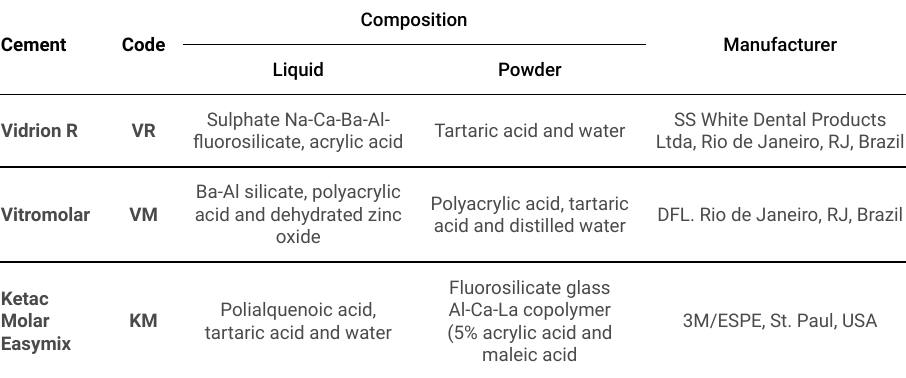
Table 1. Composition of the conventional glass ionomer cements used in this study